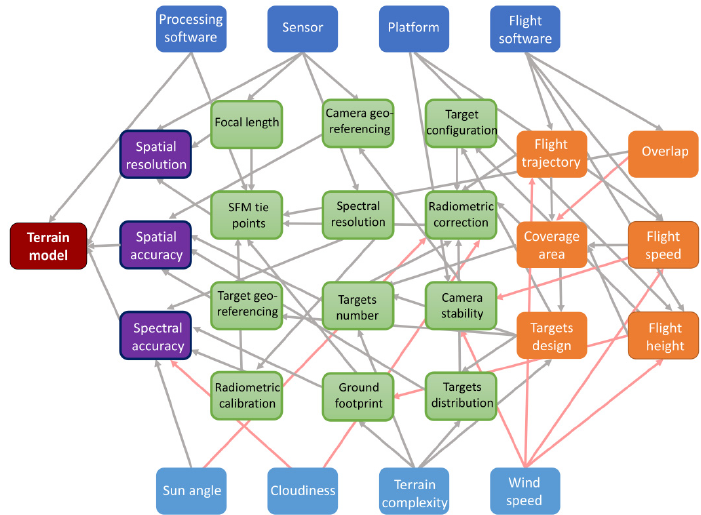
Figure 2. The influence of various study conditions on the output quality of an UAS observation: red—output product; purple—quality parameters; blue—software and hardware; orange—experiment design; light blue - environmental conditions; green—internal (affected) parameters. The arrow color indicates the type of relationship: gray—direct dependence, orange—inverse dependence.